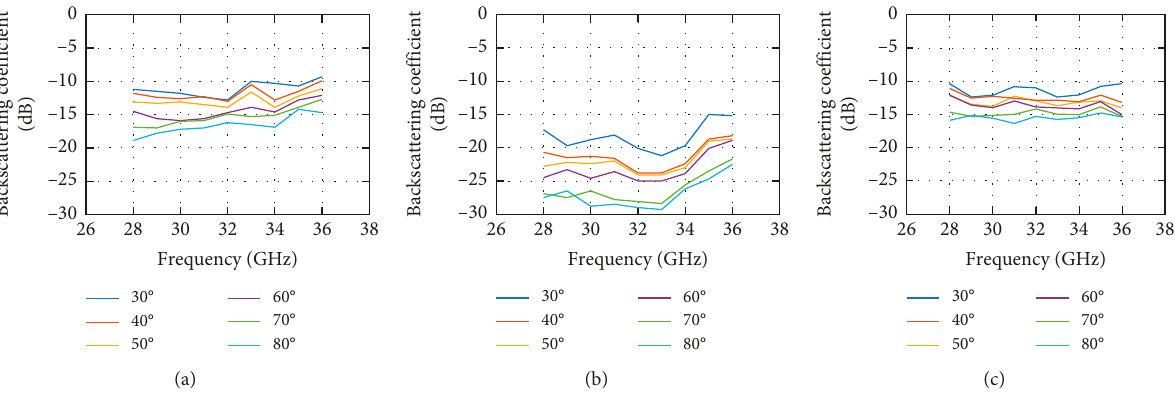
Figure 7: Frequency responses of the backscattering coefficient for the pine tree in (a) HH, (b) HV, and (c) VV polarizations.